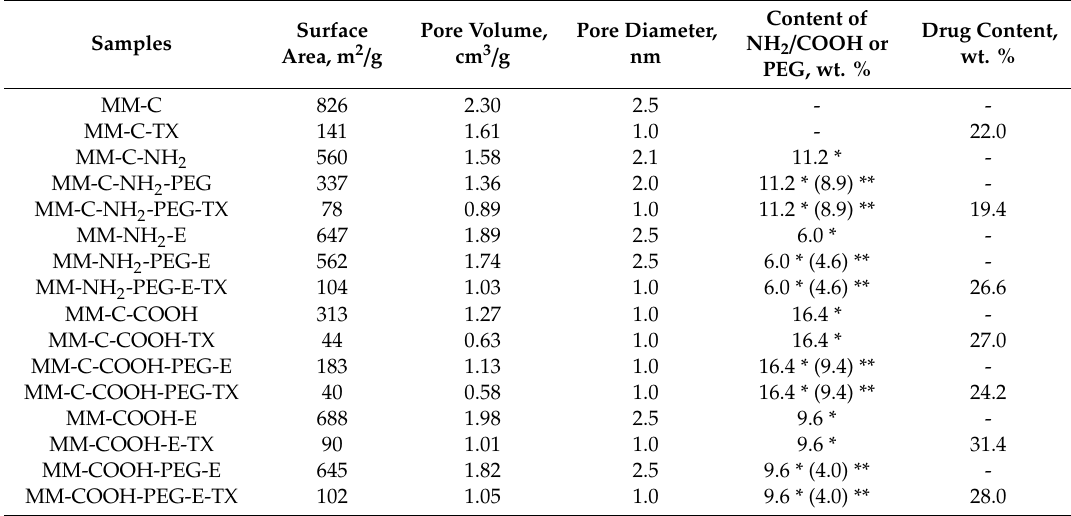
Table 1. Textural characteristics of the initial MM, MS-NH 2 , and the tamoxifen-loaded MS-NH 2 samples.